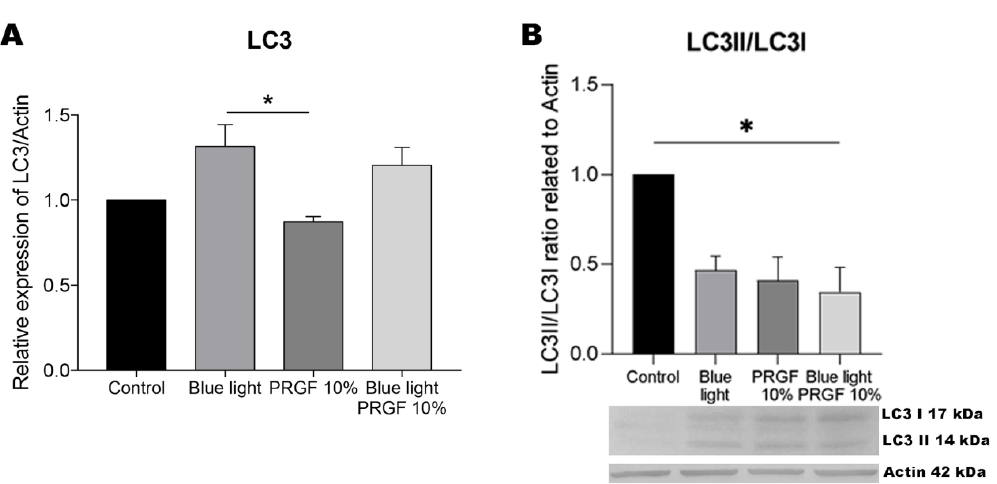
Figure 6. LC3 gene expression, and protein expression relative to the expression of actin. ( A ) LC3 gene expression measured by qPCR. Results indicate that in response to blue light, its gene expression was significantly increased compared to the PRGF treatment. It was also possible to see a difference between control and blue light treatments, however it was not significant ( p = 0.1065). One-way ANOVA, Tukey ’ s multiple comparisons test, * p < 0.05 ( n = 4). ( B ) LC3II:LC3I ratio of protein expression measured by Western blotting. Results indicate that PRGF plus blue light led to a significant increase in the expression of LC3I compared to the control treatment. One-way ANOVA, Tukey ’ s multiple comparison test, * p <